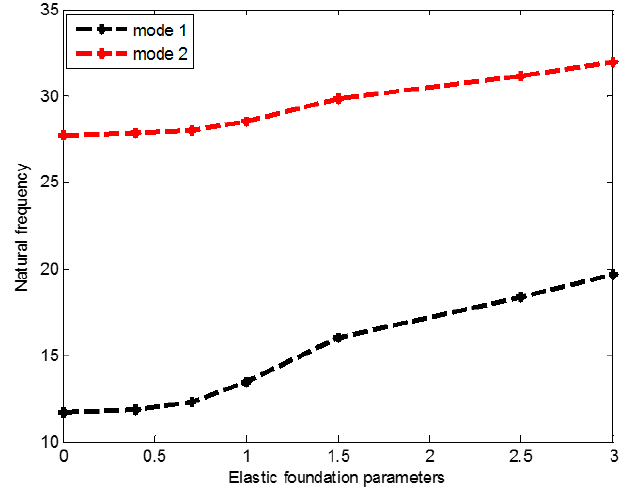
Figure 6. Variation of elastic foundation parameter on SF edge condition